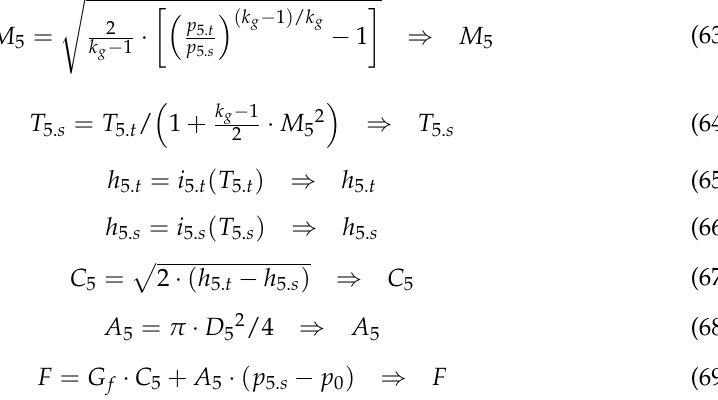
Figure 8. TV2-117A bellmouth instrumentation.